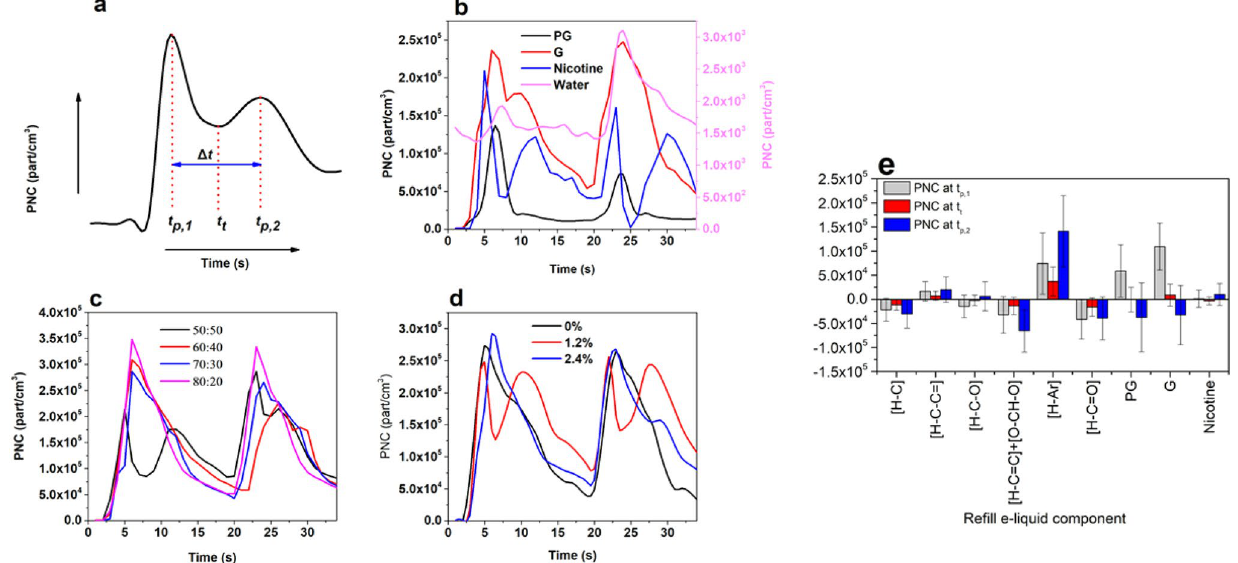
Figure 2. ( a ) Schematic representation of PNC over time and characteristics time points (first PNC peak at t p,1 ; second PNC peak at t p,2 , time difference between two PNC peaks (Δt) and time of the local minimum (trough, t t ) between two peaks; PNC for two consecutive puffs for ( b ) reference solutions of PG, G, water, nicotine, ( c ) nicotine and flavorings-free mixtures of PG: G (50:50, 60:40, 70:30 and 80:20 by volume), ( d ) commercial flavored e-liquids with variable nicotine content a , and ( e ) contribution of refill e-liquid components a on PNC at t p,1 , t t and t p,2 . Experiments were carried out using a 2 s puff and 15 s wait time at 100 W (n = 16). a refill e-liquid composition was characterized using proton nuclear magnetic resonance ( 1 H-NMR) spectroscopy 23 . part/cm 3 particles per cubic centimeter, s micrometer, PG propylene glycol, G glycerol, [H–C] saturated aliphatic, [H–C– C=] unsaturated aliphatic, [H–C–O] saturated oxygenated, [H–C=C] vinylic, [O–CH–O] acetalic, [H–Ar] aromatic, [H–C=O] carbonyl non-exchangeable organic